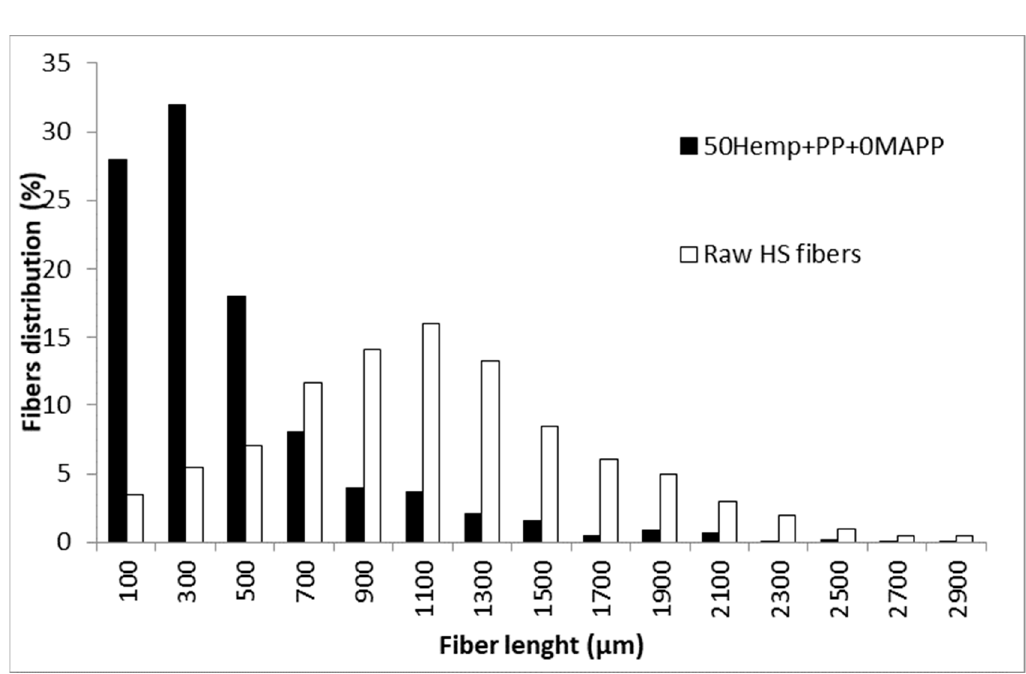
Figure 4. Fiber length distributions for the raw HS and the fibers extracted from an uncoupled composite with 50 wt % HS contents.